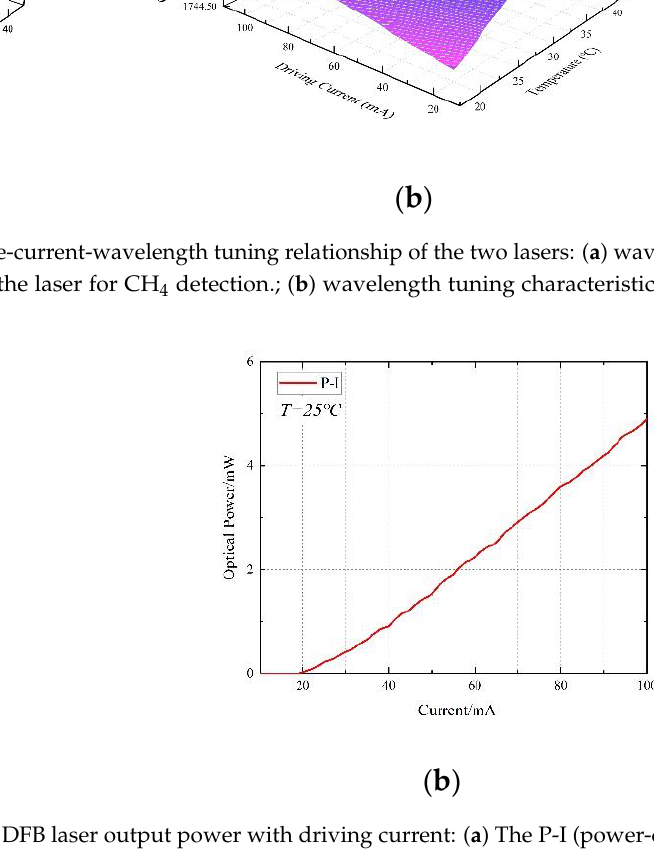
Figure 4. The temperature-current-wavelength tuning relationship of the two lasers: ( a ) wavelength tuning characteristics of the laser for CH 4 detection.; ( b ) wavelength tuning characteristics of the laser for HCl detection.